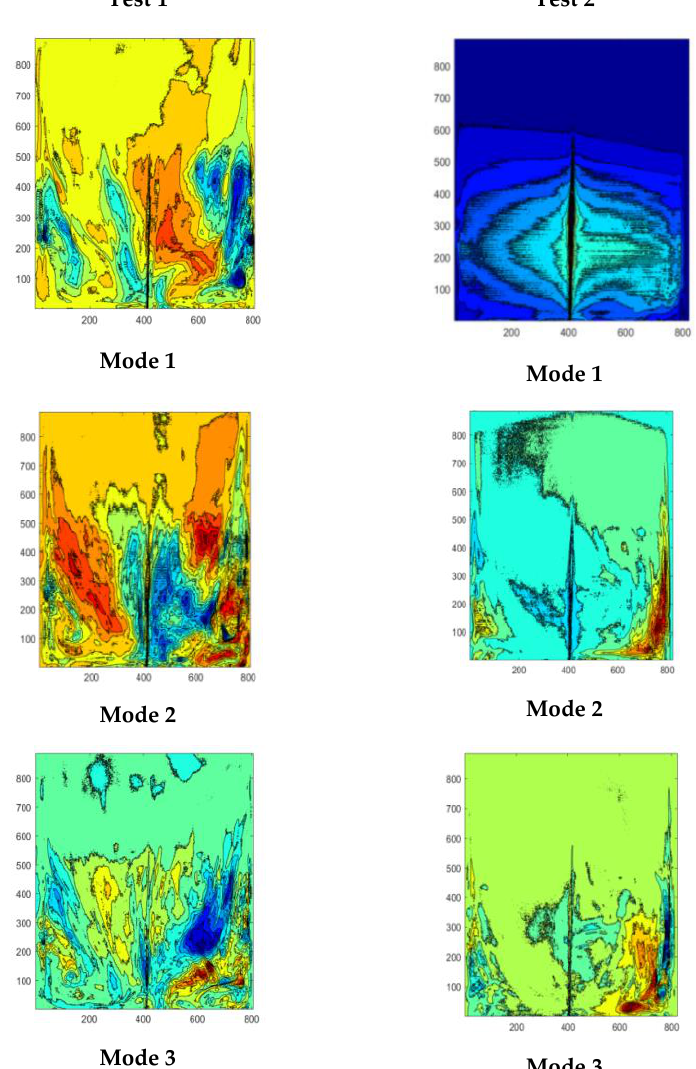
Figure 9. POD analysis of first three modes at different voltage amplitudes and fixed standoff distance of 0 mm.